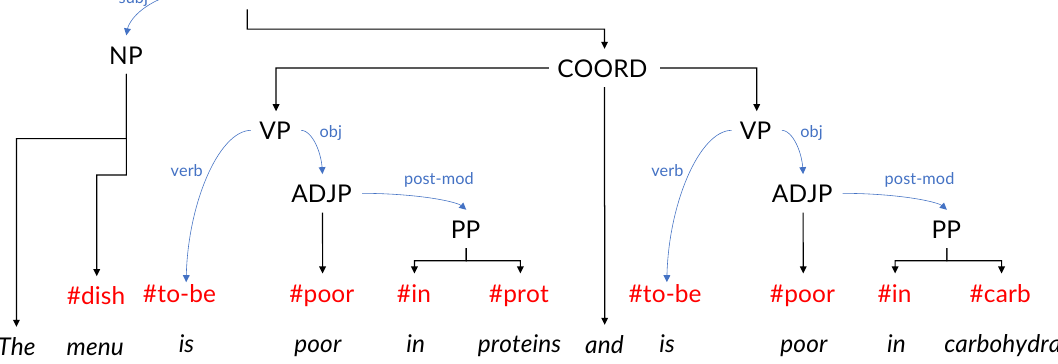
Figure 6. The quasi-tree obtained by using VP-aggregation on the quasi-trees in Figure